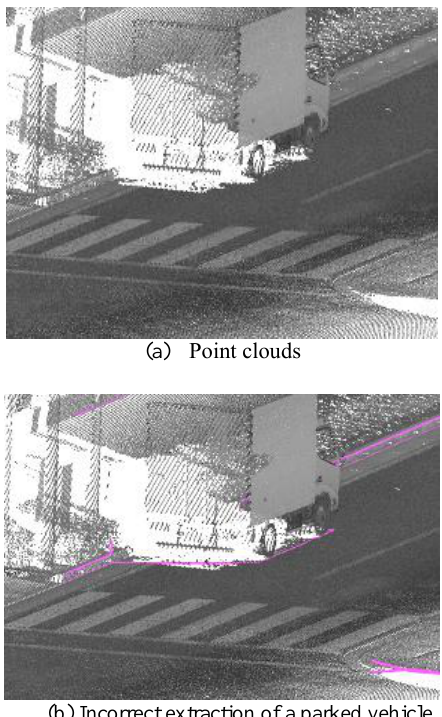
Figure 9. Mistakenly extracted due to a parked vehicle